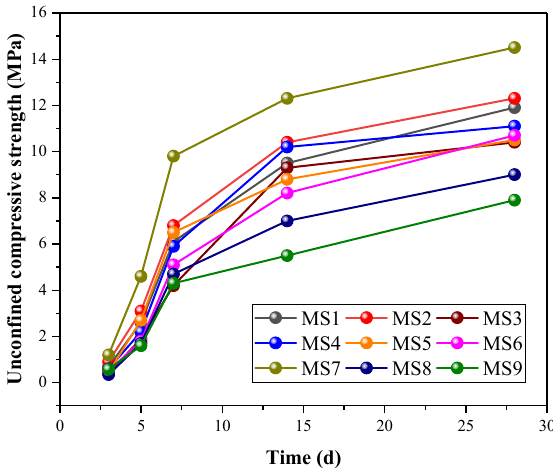
Figure 2. Unconfined compressive strength of modified dredged sludge samples.